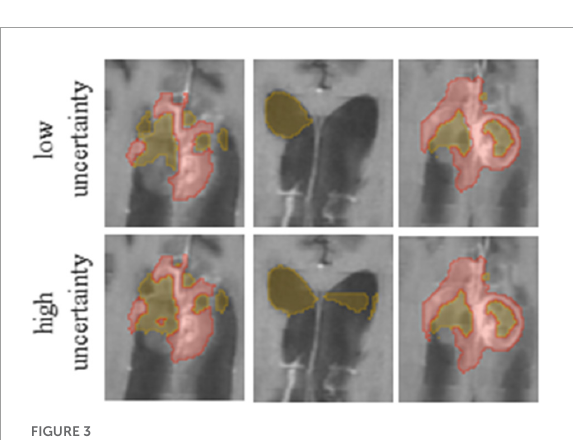
samples in the dataset. The small-loss criterion is utilized for the divergence and cross-entropy losses that are calculated voxel- wise.